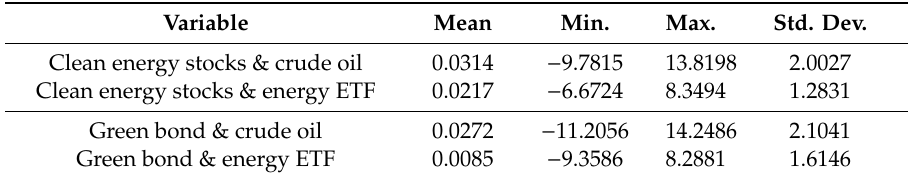
Table 6. Summary statistics of hedge portfolio